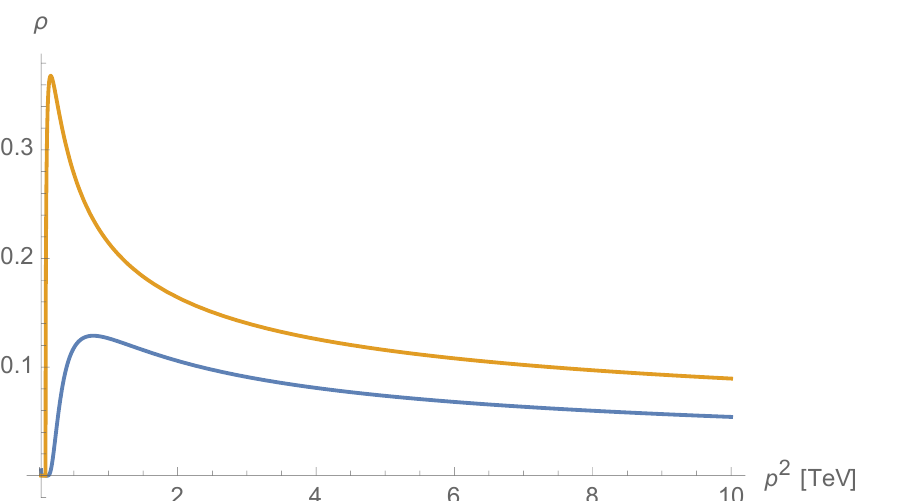
Figure 5. The spectral density function for the Minimal model as given by (4.5) (Orange, upper) and the spectral density functions for the (cid:12)rst model as given by (3.23) (Blue, lower). (cid:22) = 0 : 3 TeV, (cid:1) = 2 (cid:0) (cid:23) = 1 :